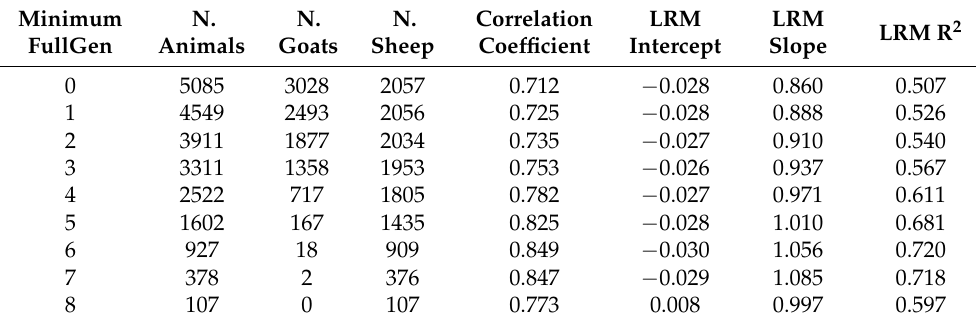
Table 2. Number of goats and sheep, F ROH -F PED correlation coefficients and p -value, and linear regression model (LRM) coefficients and R 2 per minimum class of fully traced generations in the pedigree (FullGen).